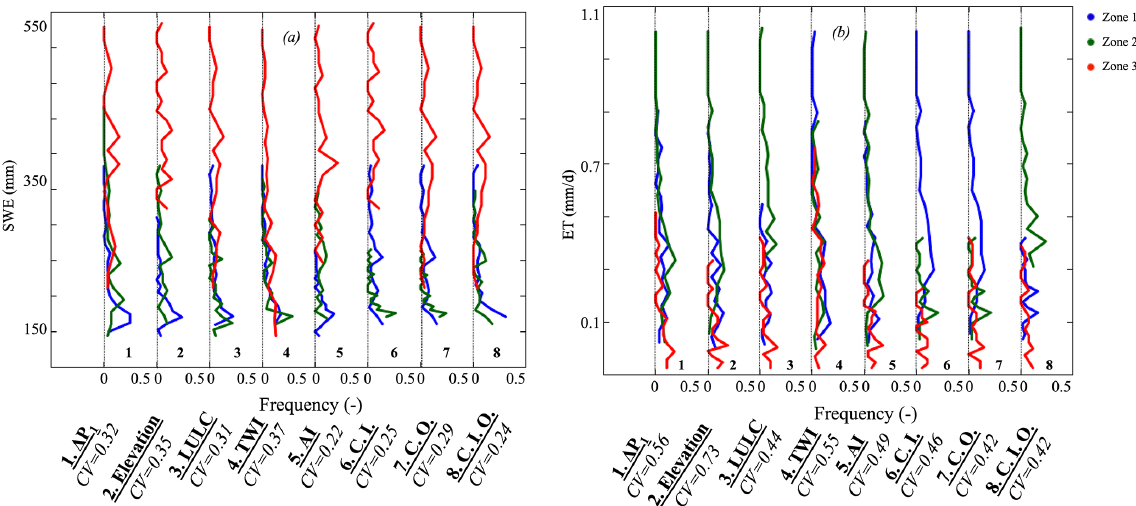
Figure 8. Frequency distributions of hillslope land surface variables: (a) annual average SWE and (b) annual average daily rates of ET. Clustering approaches are based on (cid:49)P 1 , elevation, land cover (LULC), topographic wetness index (TWI), aridity index (AI), and machine- learning approaches (with inputs C.I., outputs C.O., and inputs and outputs C.I.O.). Hillslope clustering approaches are located across the x axis. Note that we plotted the distributions of the eight clustering approaches on the same graph and between each dotted line (frequency from 0 to 0.5), the frequency distributions of the three zones derived from the clustering are